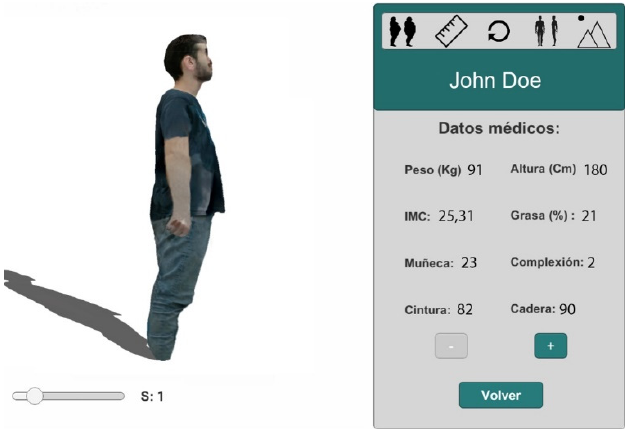
Figure 6. 4D visualization of a sequence of 3D models, fat session side view.